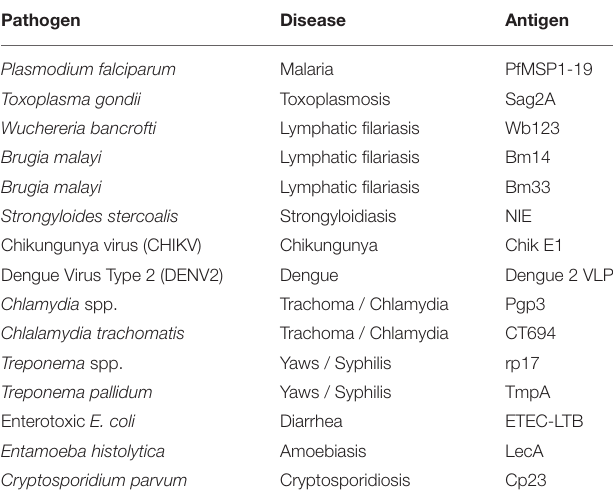
TABLE 1 | Infectious Diseases Represented and Antigens used for Multiplex Serology. Pathogen